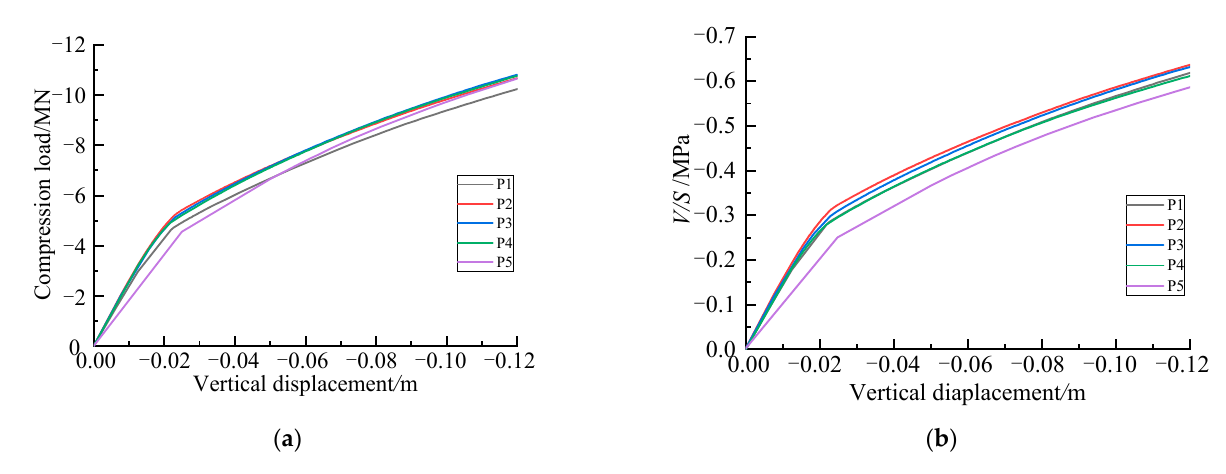
Figure 12. Compression bearing characteristic curves of helical pile with various pitches. ( a ) Load- displacement curves; ( b ) Vertical force/blade area ( V/S) -displacement curves.